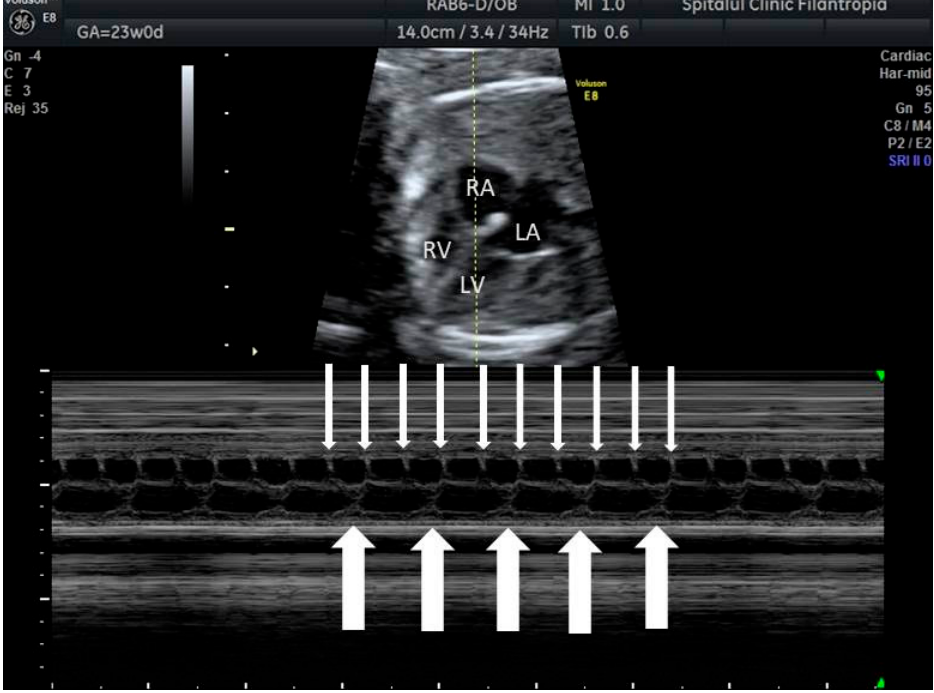
Figure 7. Complete (third degree) fetal heart block. Thin arrows indicate atrial contractions, thick arrows indicate ventricular contractions; there is AV dissociation.